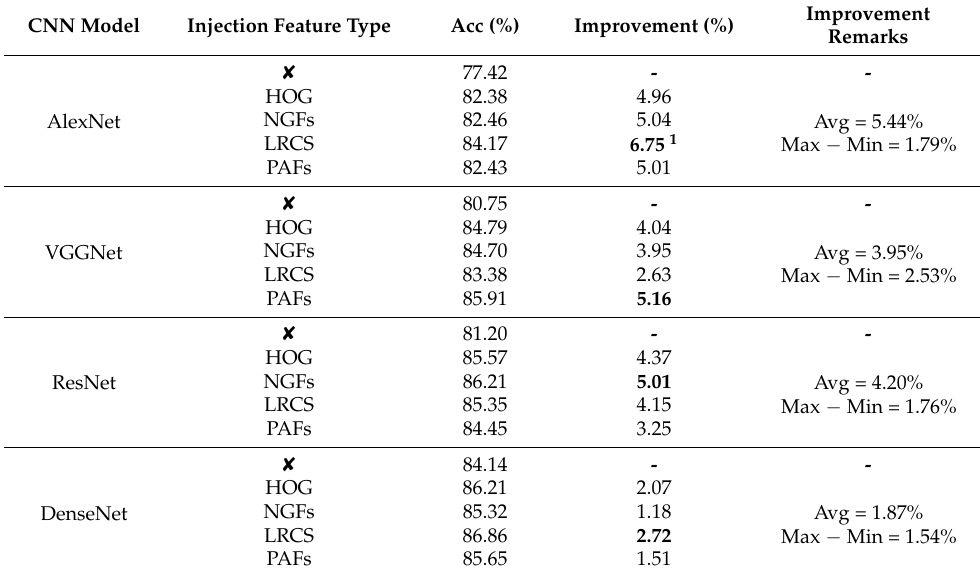
Table 5. SAR ship classification results on the FUSAR-Ship dataset with and without injection.